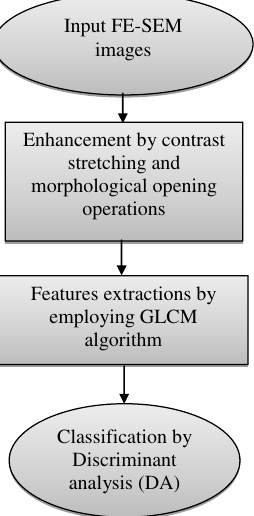
Fig. 2. Process °ow chart of the computer-aided screening system for cervical precancerous